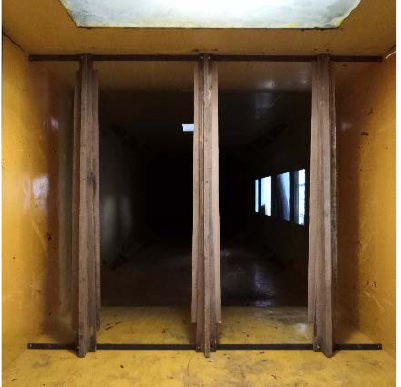
Figure 5. Spire turbulence field installed in XNJD-1 wind tunnel.